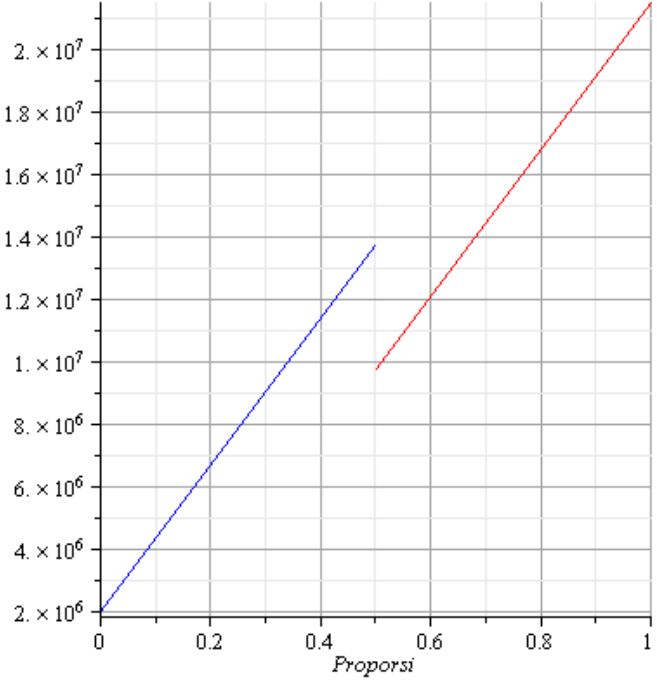
Figure 1. Surface line graph of natural disaster insurance premiums.